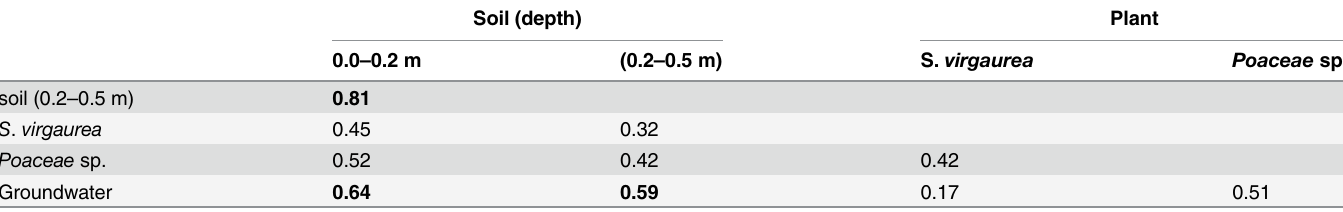
Table 1. Correlation coefficients of Spearman correlation between the content of THg in soil, plants and groundwater.